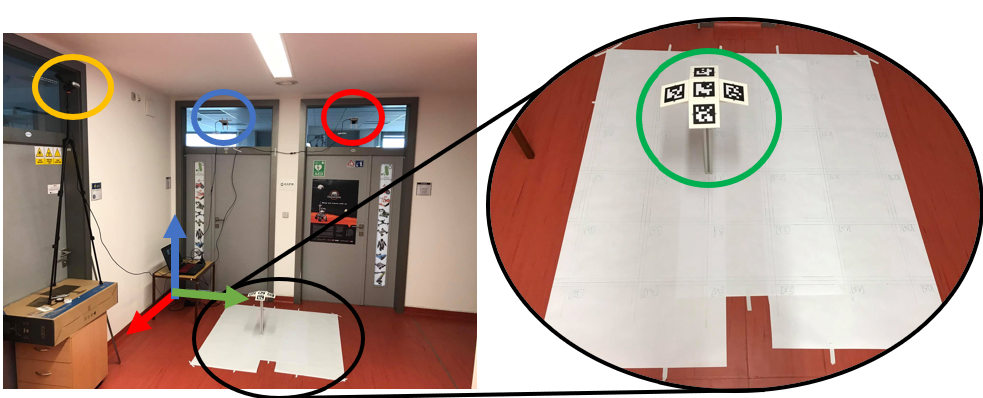
Figure 5. Real test: the cameras are highlighted with yellow, blue, and red circles. The gridboard is in a green circle representing the position of an automated guided vehicles